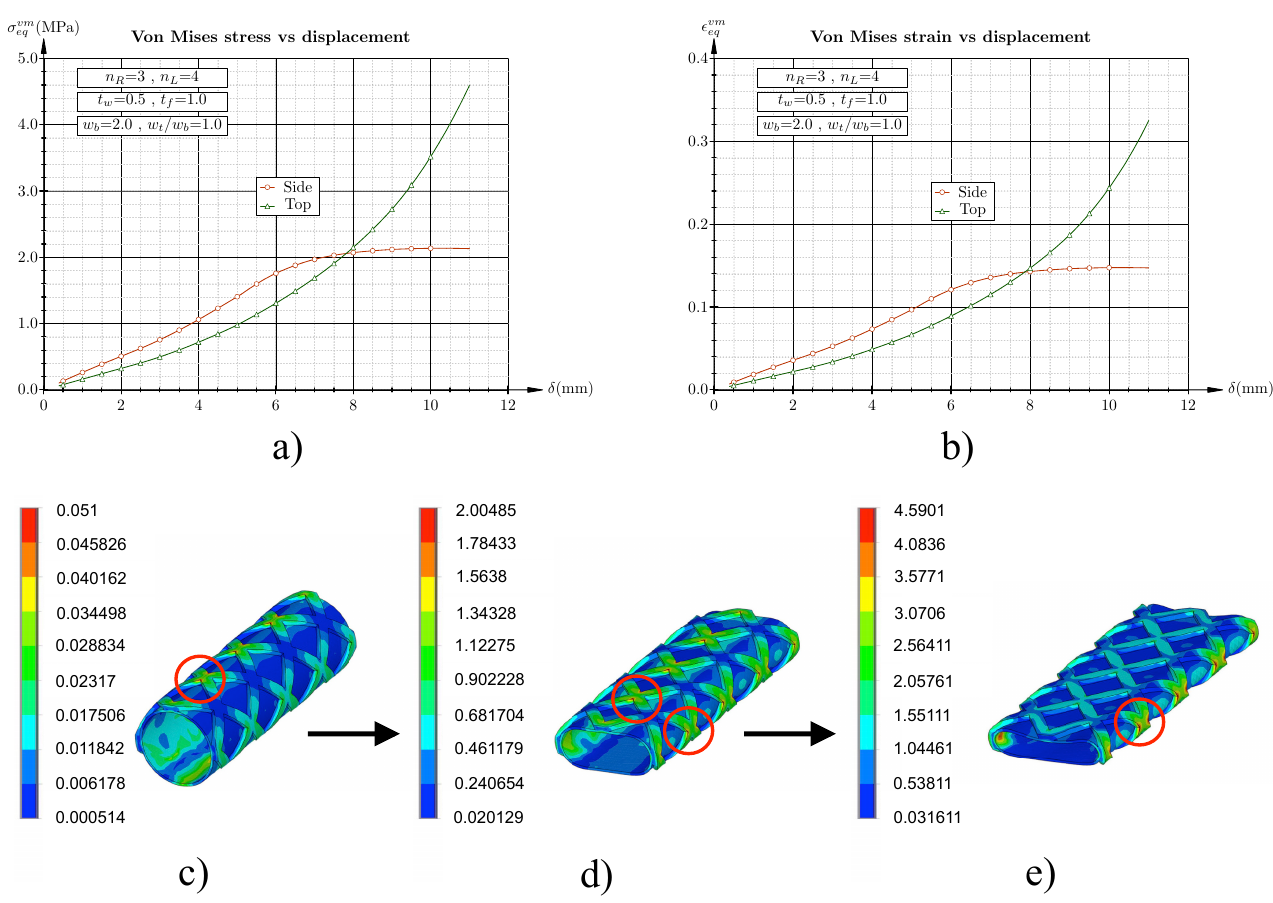
Figure 13. Evolution of the equivalent Von Mises stress ( a ), and strain ( b ) during the compressive load simulation for a specific node on the top and side of the prosthesis. The stress distribution on the prosthesis (in [MPa]) during the compression is sketched at different instants during the compression in ( c – e ). The red circle highlights the location of the maximum equivalent Von Mises stress.